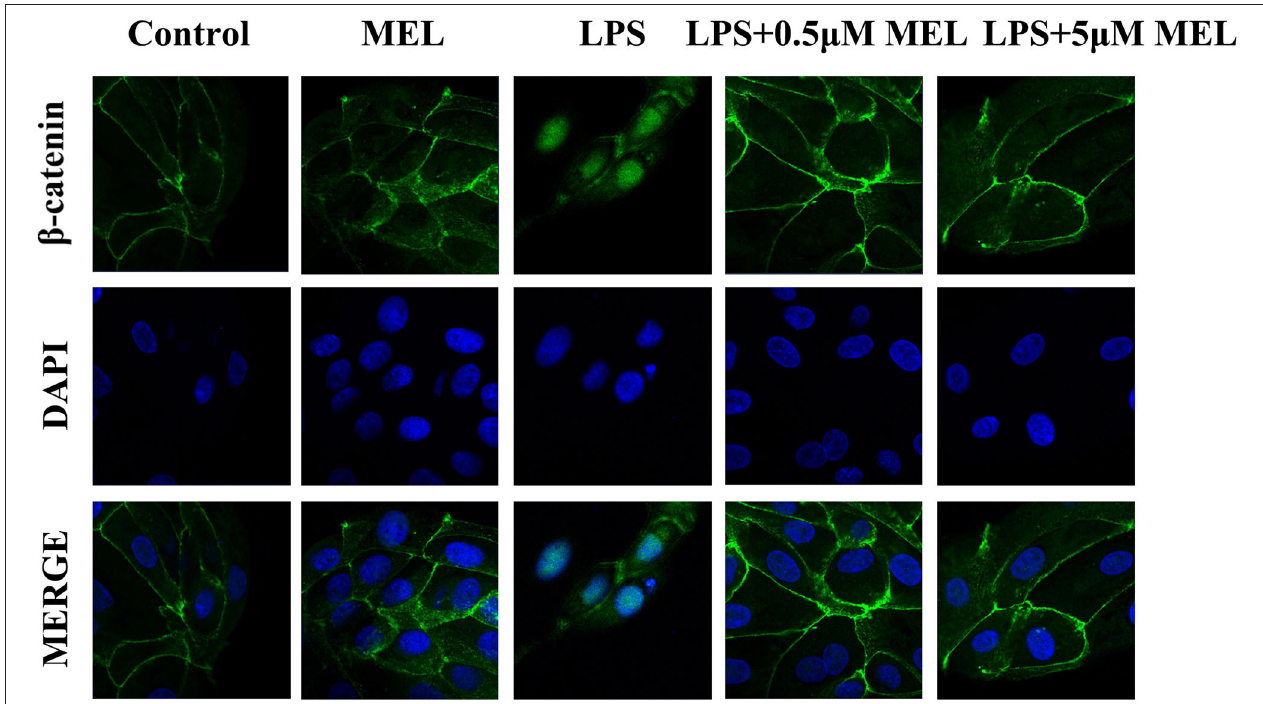
FIGURE 10 | The effect of meloxicam on Wnt/ β -catenin activation in bovine endometrial epithelial cells. LPS, lipopolysaccharide; MEL, meloxicam. The cells were treated with LPS or MEL (0.5 µ M) or co-treated with LPS and MEL (0.5 and 5 µ M) for 15min. The β -catenin were observed by confocal microscopy. All data were presented as means ± SEM ( n =